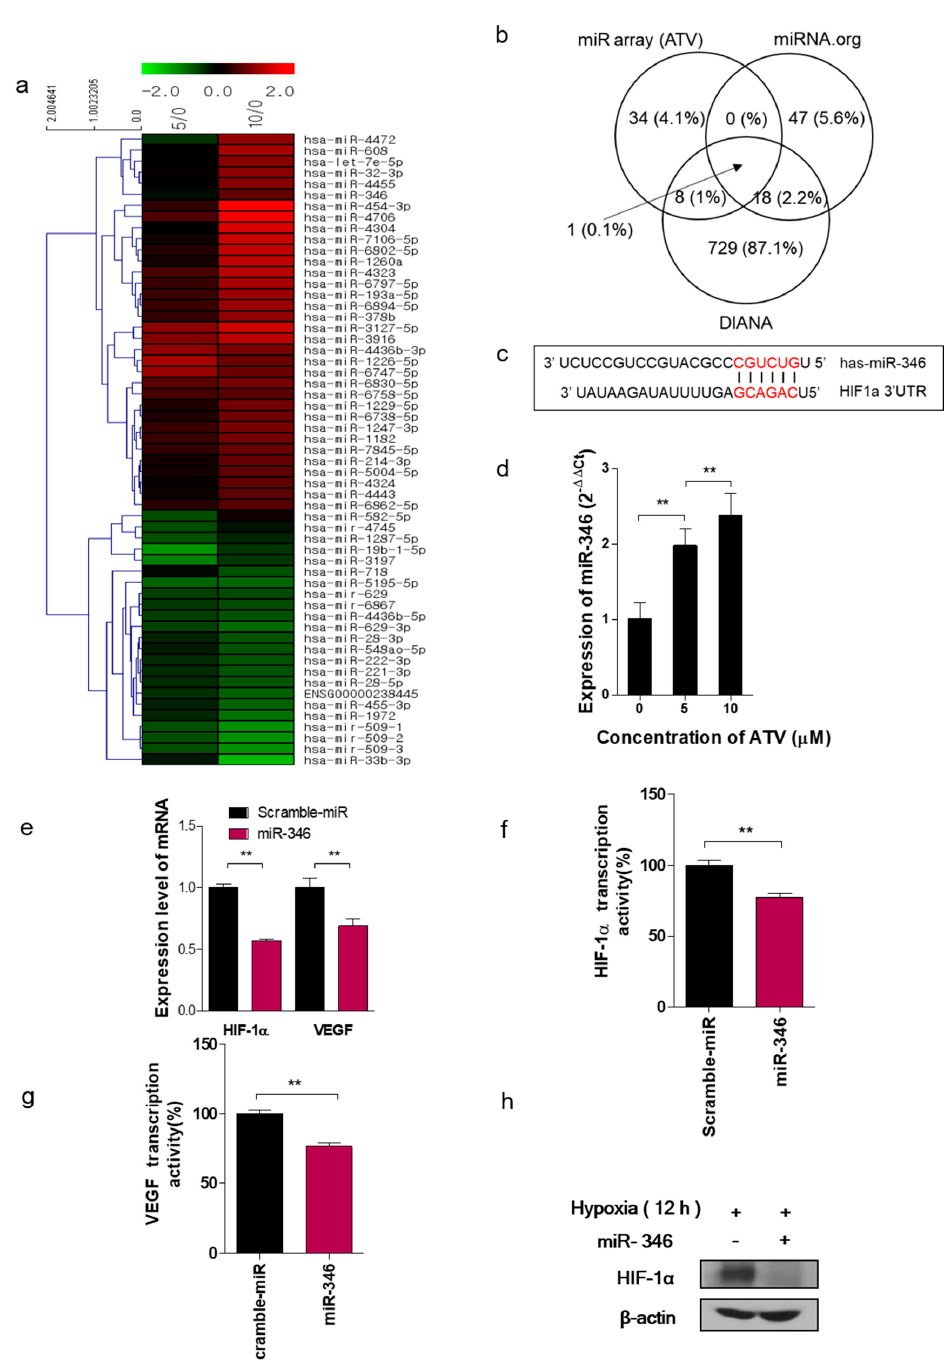
Figure 4. Target relationship between miR-346 and HIF-1a in the Raji cells. ( a ) Hierarchical clustering of miRNA expression reveals a descending ordered list of significant miRNA clusters in the untreated control cells. ( b ) Venn diagram presenting the number of putative miRNA candidates by two prediction programs and microRNA microarray. ( c ) The sequence alignment of miR-346 with the 3 ′ UTR of HIF-1 α gene was searched in the miRNA database. ( d ) The relative expression of miR-346 in Raji cells was analyzed according to the concentration of ATV via qRT-PCR (** p < 0.005). ( e ) The mRNA expression of HIF-1 α and VEGF was measured by using qRT-PCR after miR-346 treatment in Raji cells. ( f ) The level of HIF-1 α determined by ELISA after miR-346 transfection (** p < 0.005). ( g ) The level of VEGF determined by ELISA after miR-346 transfection (** p < 0.005). ( h ) The protein expression of HIF-1 α determined by western blotting in hypoxia-induced-Raji